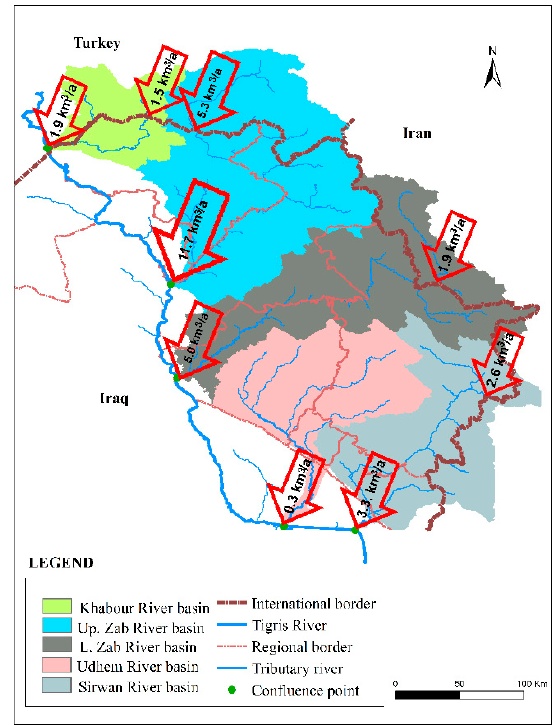
Figure 1. Location of river basins in Kurdistan (Iraq), and the inflow and outflow water balance of the Kurdistan Region.